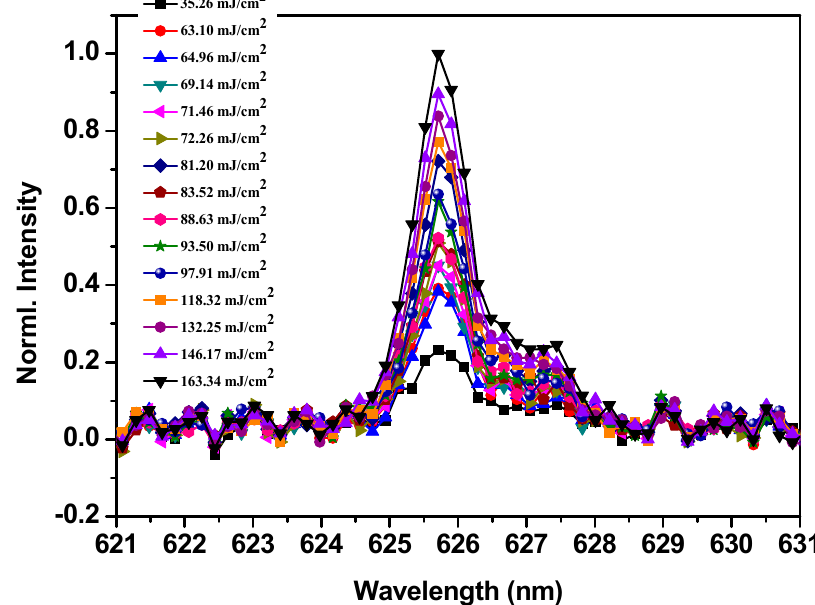
Figure 3. Emission spectra of the P5T single crystal pumped at an excitation wavelength of 445 nm with different pulsed energies.